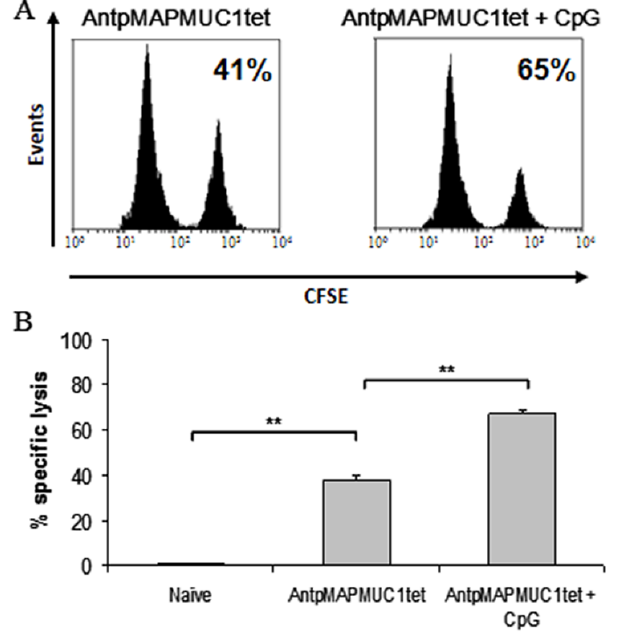
Figure 10. Long term cellular immune responses in AntpMAPMUC1tet immunised mice, measured as in vivo CTL killing assays. ( A ) C57BL/6 mice were immunised i.d. with PBS, 100 µ g AntpMAPMUC1tet or 100 µ g AntpMAPMUC1tet + 50 µ g CpG and the percent MUC1K b -specific